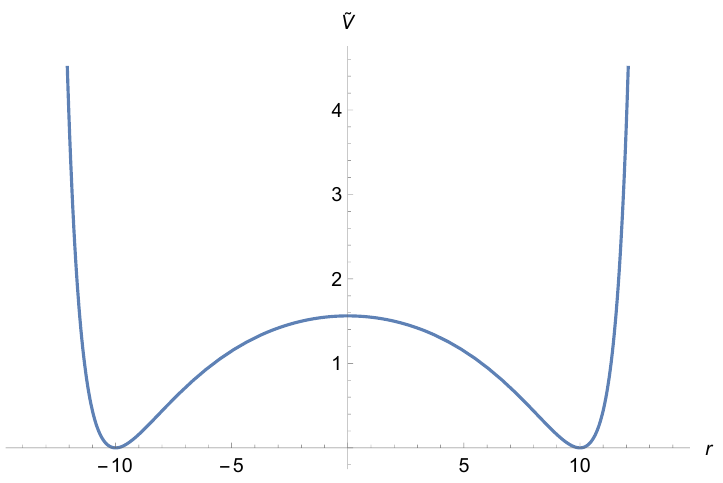
Figure 5 . ˜ V with parameters G = 2 , c = 0 . 1 , r A = 1 , M = 1 , (cid:15) = 0